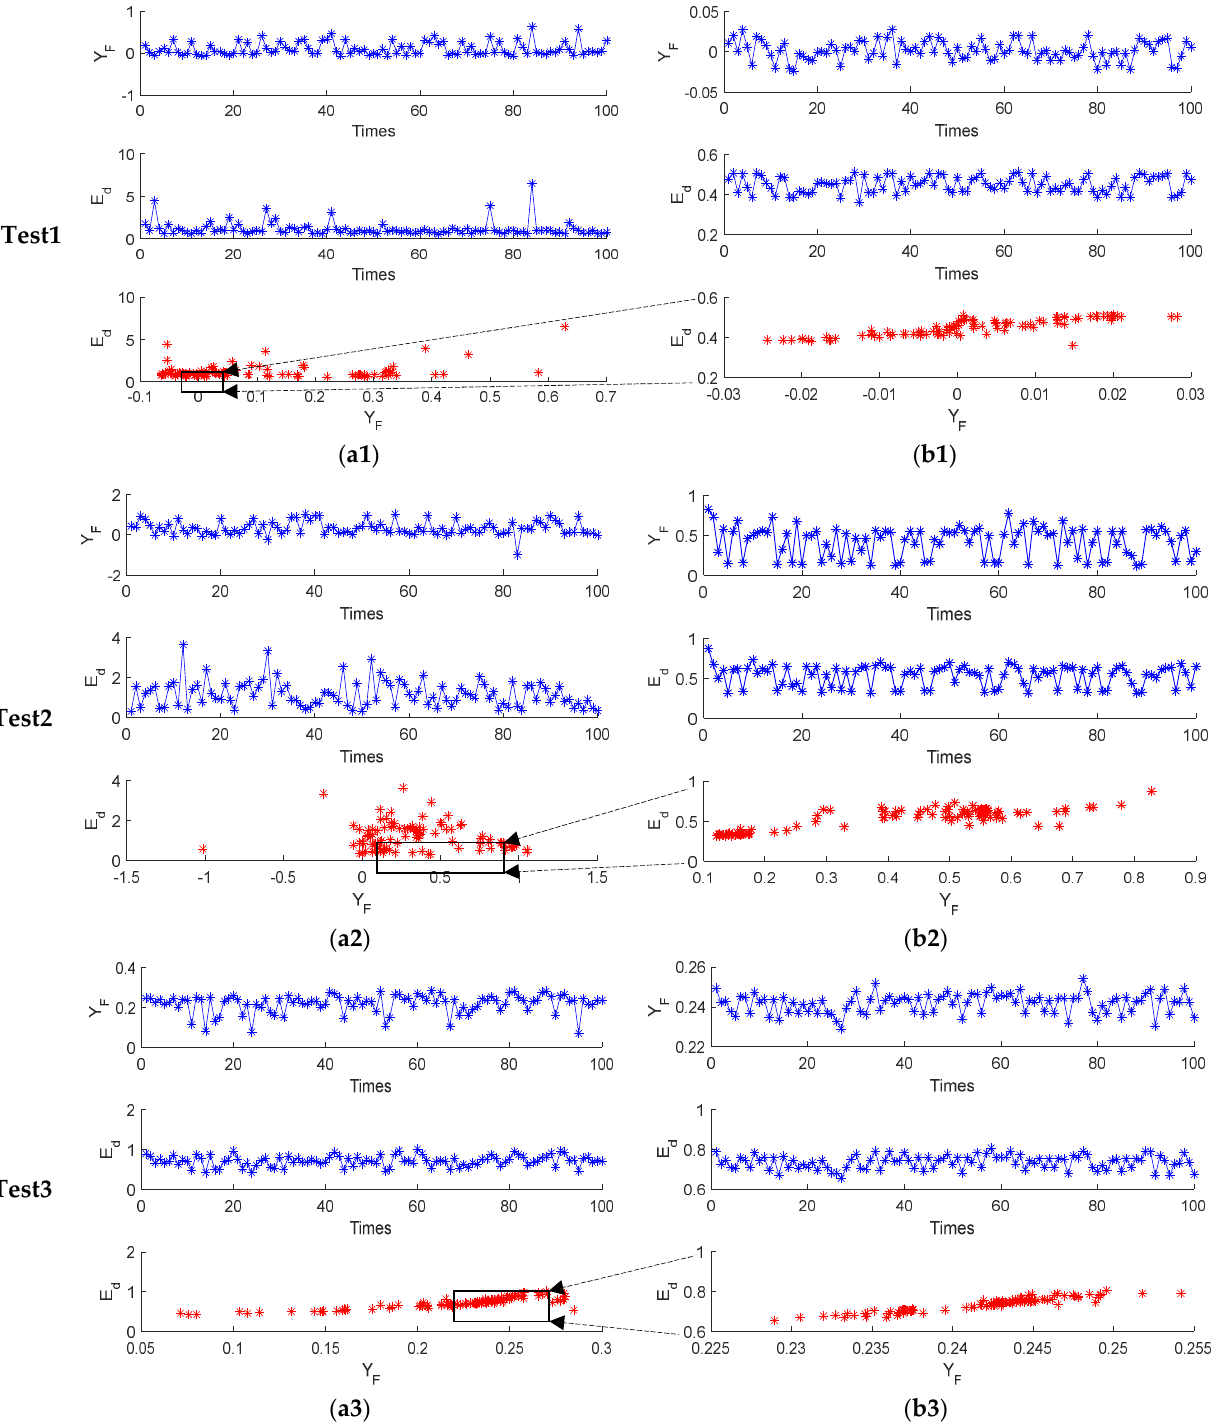
Figure 8. Distribution results of Y F and E d . There are the results of test1, test2, and test3 in ( a1 , b1 ), ( a2 , b2 ) and ( a3 , b3 ), respectively.